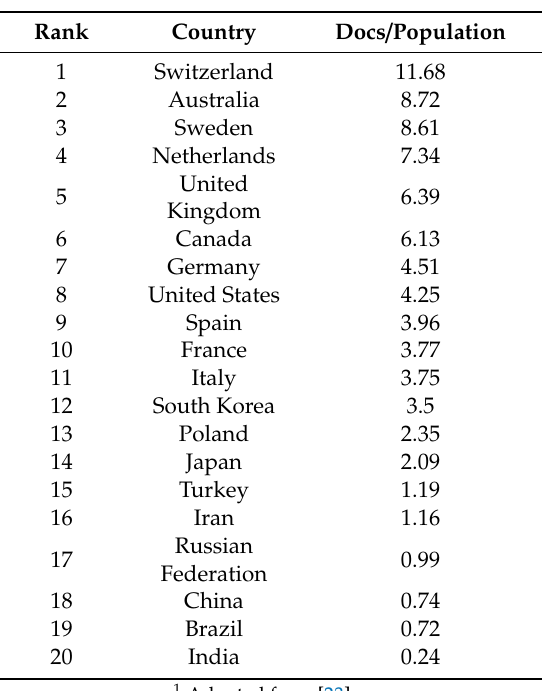
Table 3. Comparison of scientific output and GDP 1